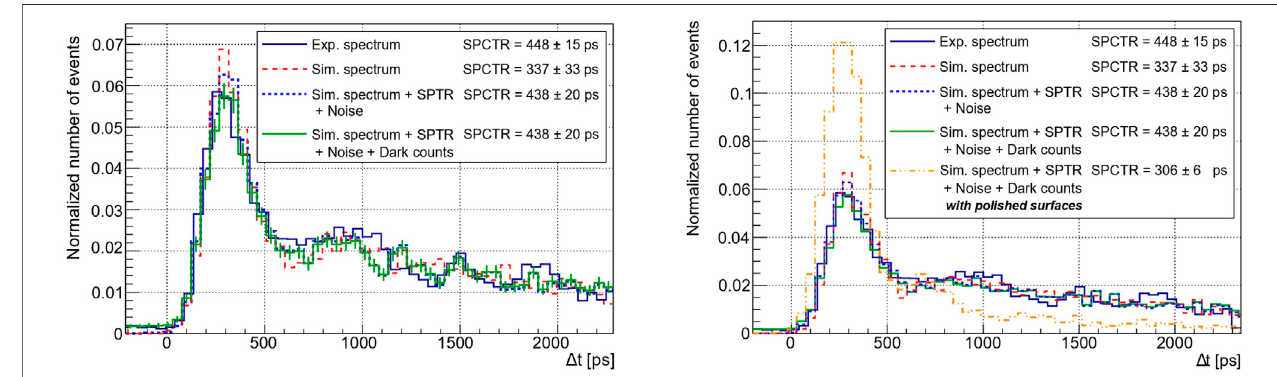
FIGURE7|(A) SimulationofthephotodetectorcontributionsaffectingSPCTRandtheirimpactonthecoincidencetimedistribution,selectingeventswithonedetected photon. The Te fl on-wrapped TlBr crystal with dimensions 3 × 3 × 20 mm 3 is considered, with the 3 × 3 mm 2 side in coincidence with the reference detector. The corresponding measured time distribution is shown in superposition. (B) Comparison with the simulated time distribution assuming the crystal with polished